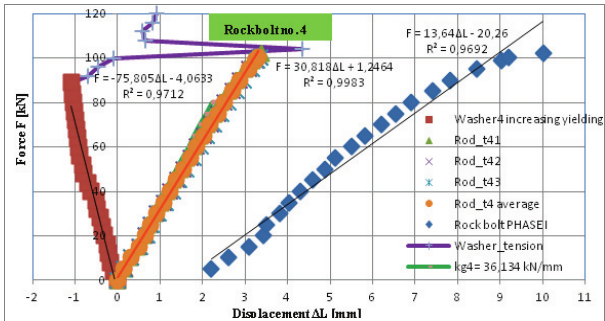
Fig. 23. The detailed loading characteristics for the components of the rock bolt support No. 4